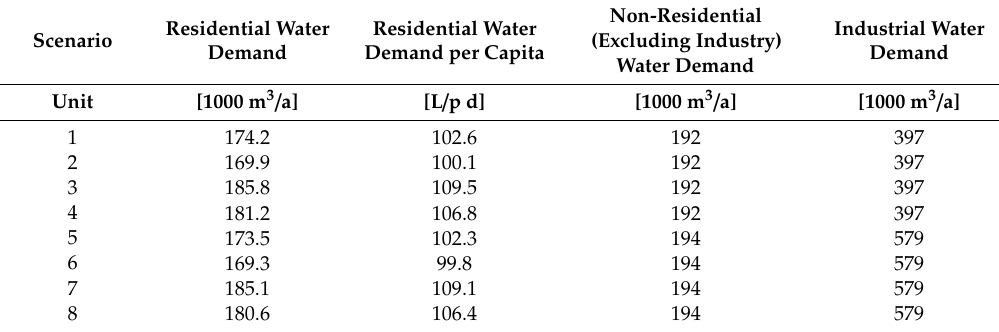
Table 9. Simulation results of case study